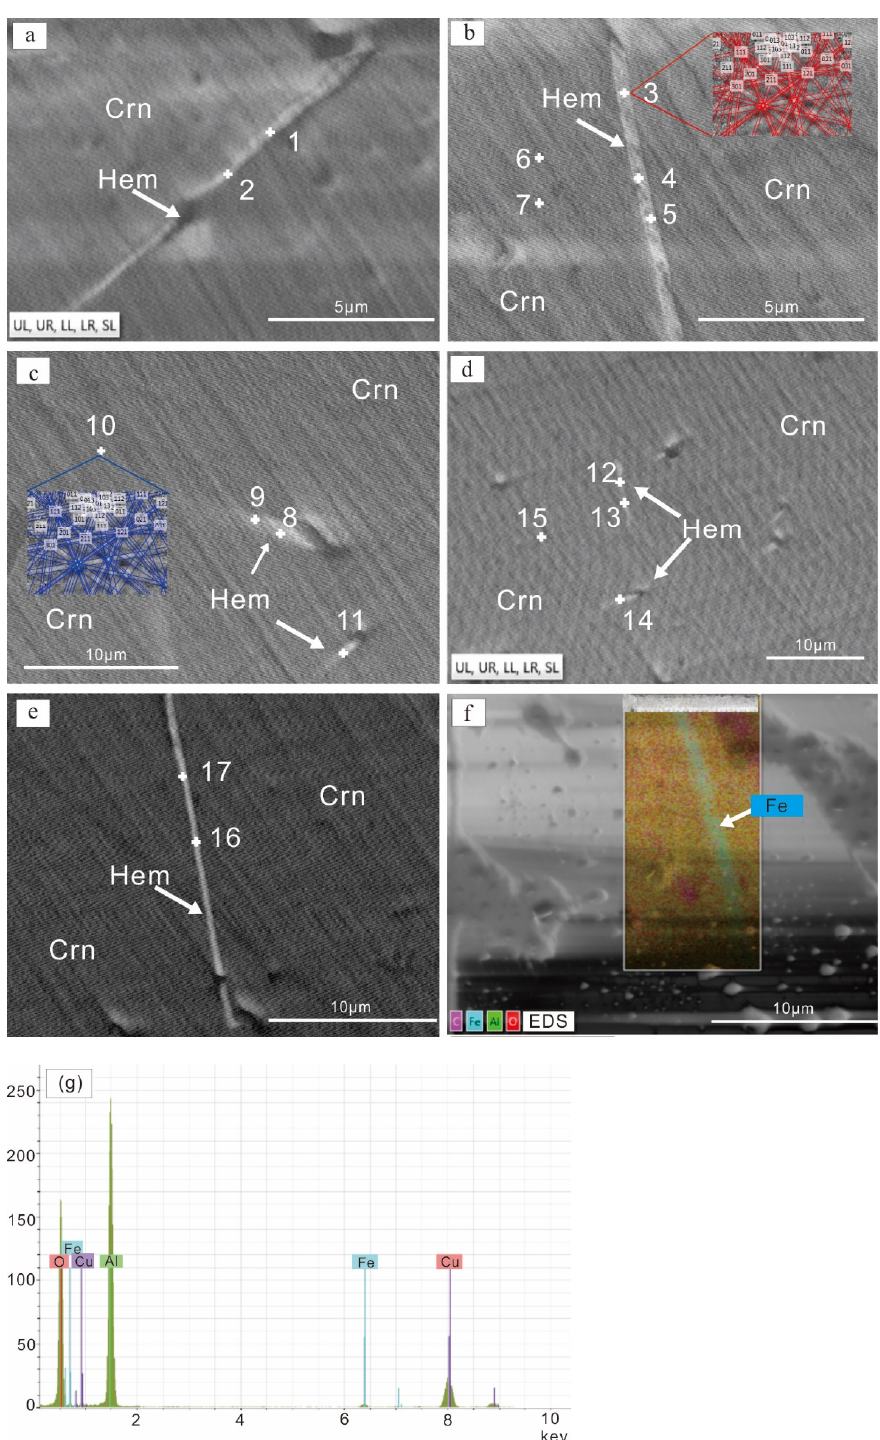
Figure 4. SEM-BSE, EDX and EDS results of the exsolutions and the host. Crn represents for corun- dum, Hem for hematite, the symbols + and numbers (1–17) for the selected test points, respectively. ( a – e ) SEM-BSE photographs of the exsolutions and the host. Points 1–2 in ( a ), 3–5 in ( b ), 8–9, 11 in ( c ), 12–14 in ( d ) and 16–17 in ( e ) were tested on the exsolutions, and the others were tested on the corundum host. The inserted patterns in ( b , c ) are Kikuchi patterns for point 3 on the exsolution and point 10 on the host, respectively. ( f ) SEM-EDS mapping of the exsolution. Fe and O is dominate in the exsolution. ( g ) SEM-EDS spectrogram reveals that the exsolutions are mainly composed by Fe. The ordinate represents X-ray relative intensity, the Cu signal is from the copper